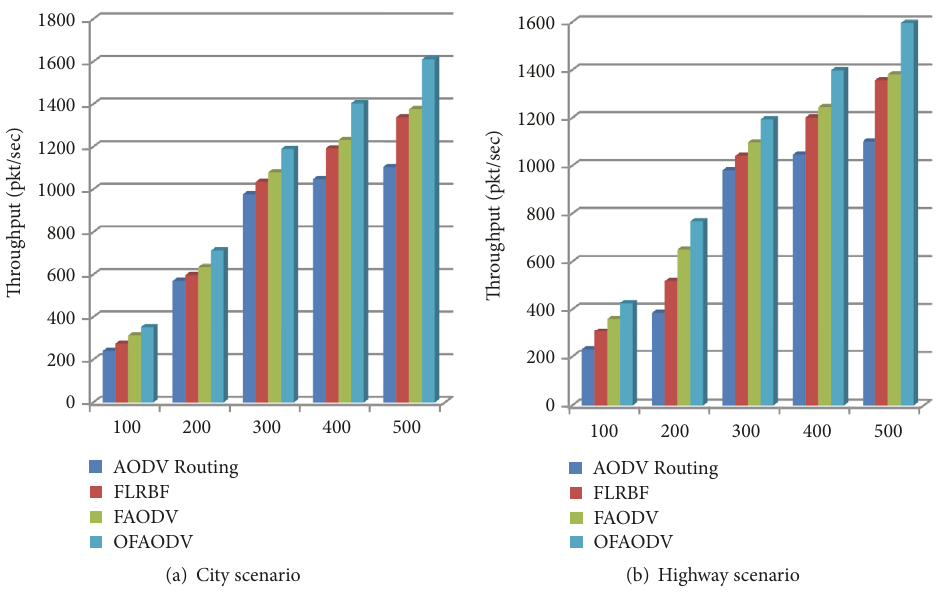
Figure 6: Throughput (pkt/sec) vs. no. of